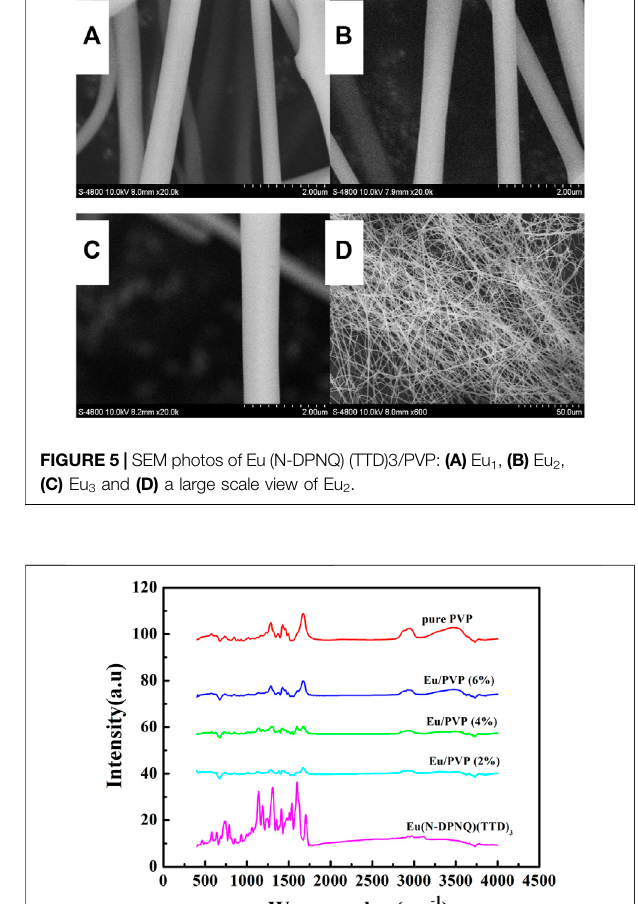
Figure 2 . The UV-vis absorption spectra of free N-DPNQ and free HTTD are shown in Figure 2 as well. The absorption bands for Eu(N-DPNQ)(TTD) 3 locating at around 227 and 275 nm, which well matches that of N-DPNQ, are assigned as introligand π - π * electron transitions of N-DPNQ. The absorption of 339 nm corresponds to the π - π * electron transition of HTTD ligand.